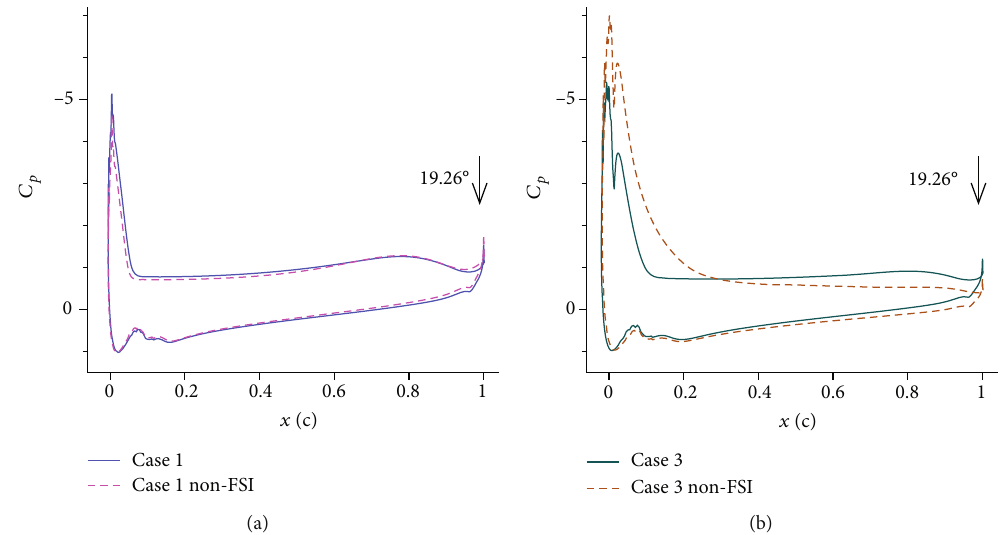
Figure 23: Pressure coe ffi cient distributions at an angle of attack of 19.26deg downstroke.